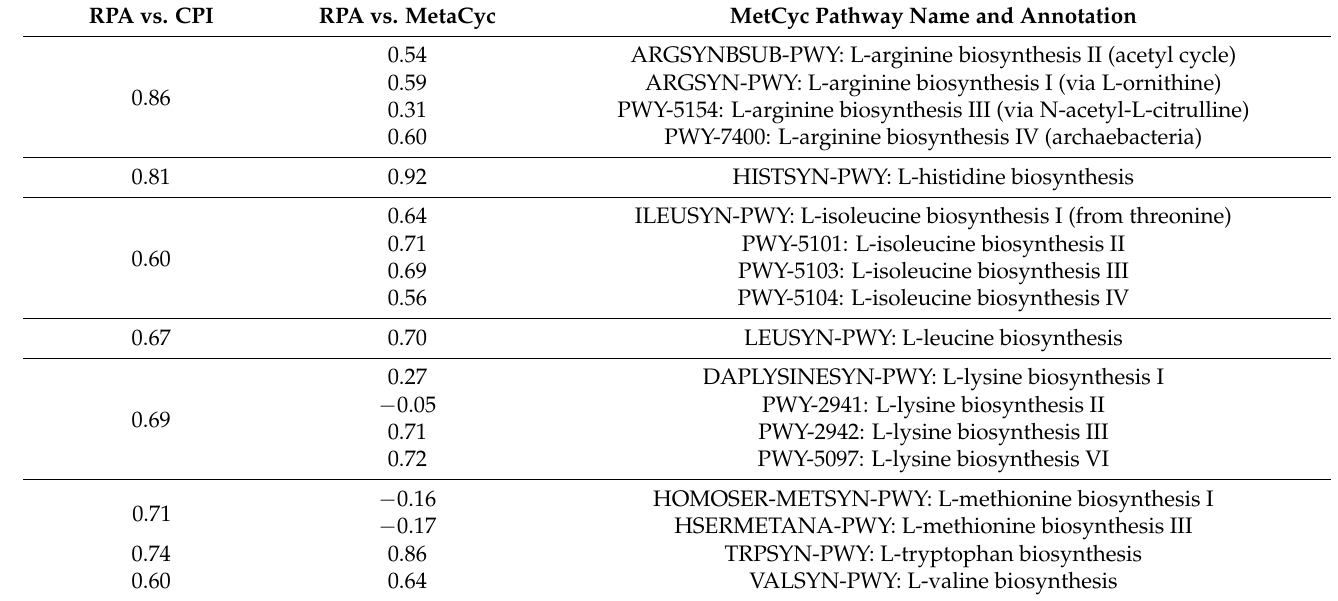
Table 3. Pearson’s correlation coefficient for comparison of CPIs, relative phenotype abundance (RPA) and relative pathway abundance (MetaCyc) for amino acid synthesis pathways obtained by PICRUST2 pipeline on HGM samples from the AGP